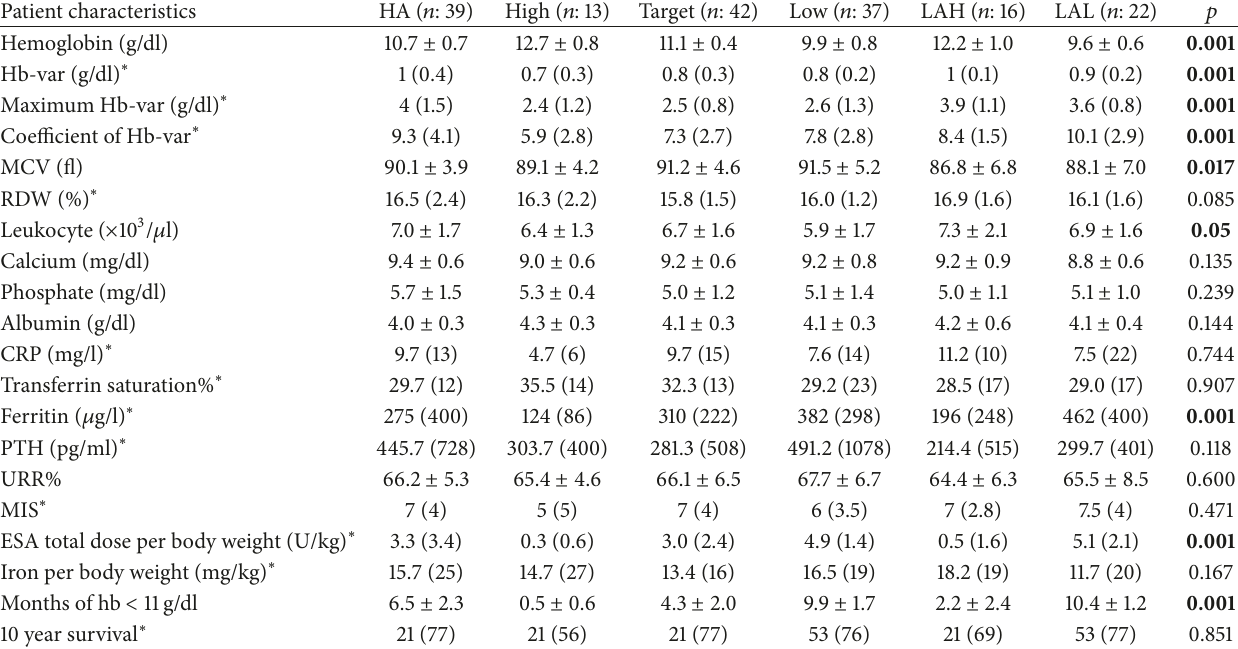
Table 2: Biochemical parameters and medications of hemoglobin